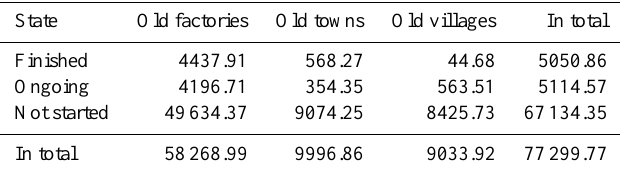
Table 1. Statistical data about the types and area of “Three Old” reconstruction.